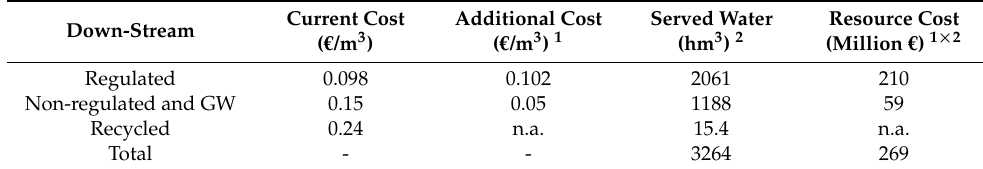
Table 7. Estimation of resource cost in the GRB.